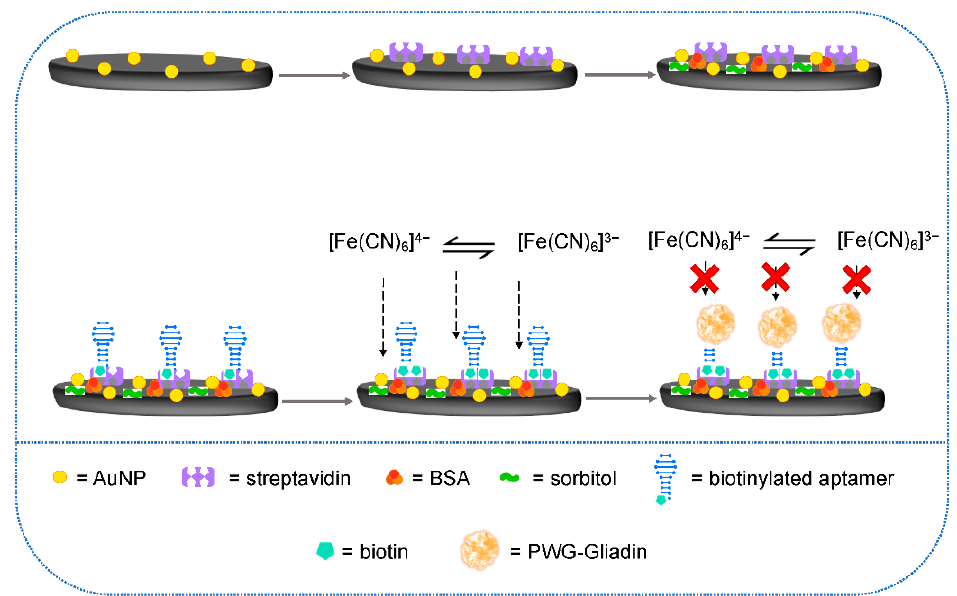
Figure 10. Scheme of the aptasensor design and sensing strategy: after the electrochemical deposition of AuNPs streptavidin was immobilized on the working electrode, then a solution of BSA and sorbitol was used to block the surface; subsequently, the biotinylated aptamer was immobilized, and after a final step of blocking with biotin, the sensor was ready to use. Reprinted from [130]. The redox probe [Fe(CN) 6 ] 4 − /3 − was employed to evaluate the presence or absence of PWG-Gliadin.